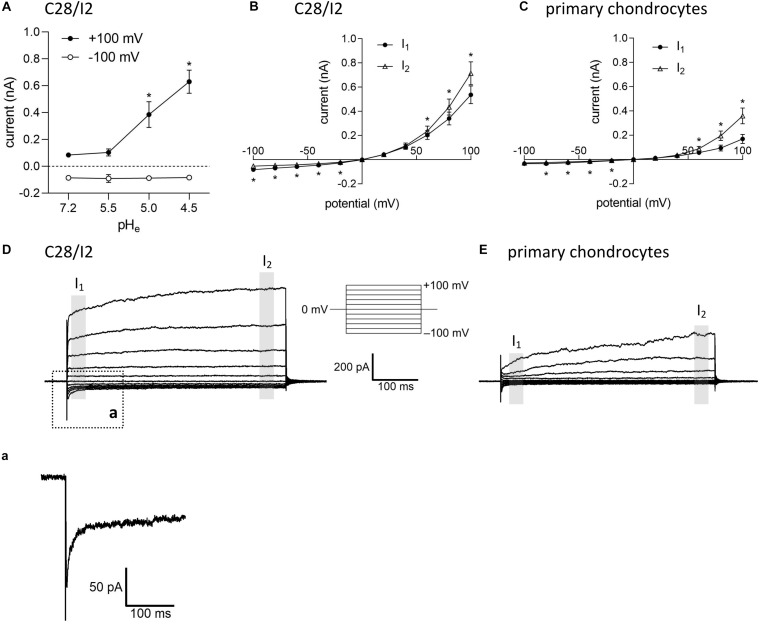
Extracellular acidification induces an acid-sensitive outwardly rectifying (ASOR) current in C28/I2 cells and primary human chondrocytes. (A) Mean amplitudes ± standard error of the means (SEM) of ASOR currents measured at pH 7.2 (n = 20), 5.5 (n = 4), 5.0 (n = 9), and 4.5 (n = 7). Asterisks indicate significant differences between pH 5.0 and pH 7.2 and between pH 4.5 and pH 7.2 (p < 0.05). Wilcoxon rank sum test. Current–voltage (I–V) relationships of mean ASOR currents ± SEM analyzed at the beginning (I1—open triangles) and at the end (I2—closed circles) of voltage pulses (indicated by gray shadings in D and E) in C28/I2 cells (n = 8) (B) and primary chondrocytes (n = 7) (C). Asterisks indicate significant differences between I1 and I2 (p < 0.05). Paired t-tests. Examples of ASOR current traces elicited by 500-ms voltage steps from –100 to +100 mV in C28/I2 cells (D) and primary chondrocytes (E). (a) Close-up of the inward current peak at –100 mV indicated in (D).